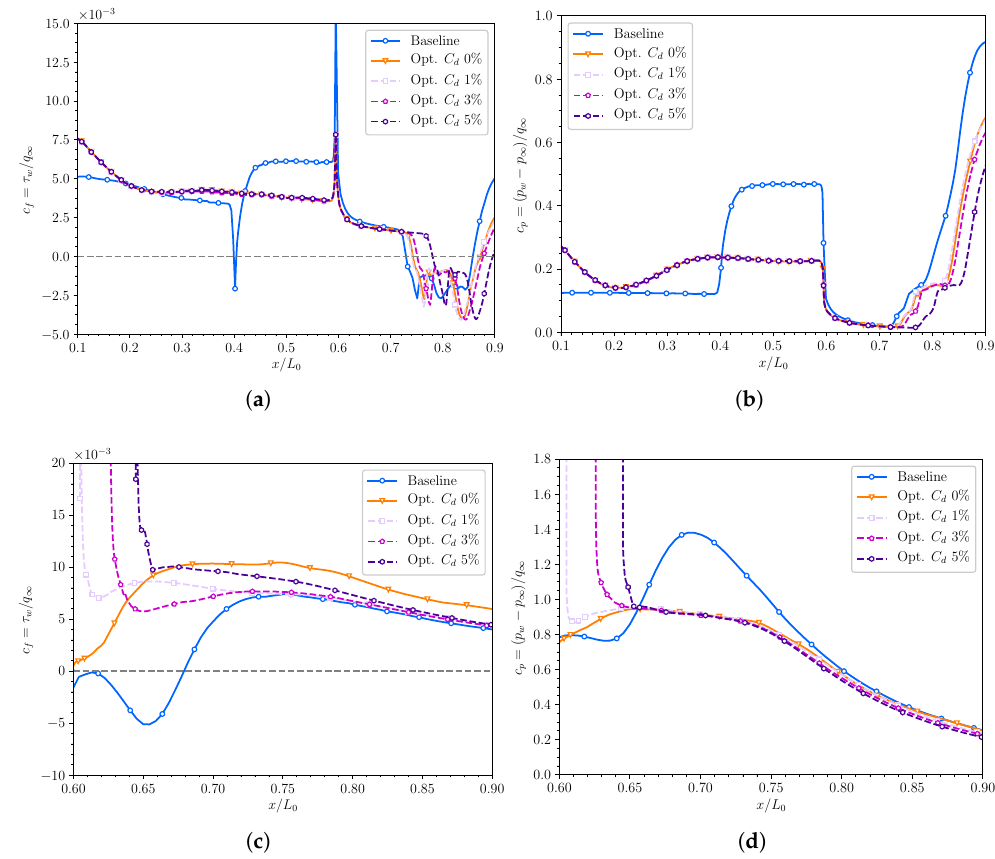
Figure 17. Friction and pressure coefficient trends along the bottom and the top surfaces for the baseline, the optimal C d design and three C d optimal-derived backward cowl lip configurations. ( a ) Friction coefficient (bottom surface); ( b ) Pressure coefficient (bottom surface); ( c ) Friction coefficient (top surface); ( d ) Pressure coefficient (top